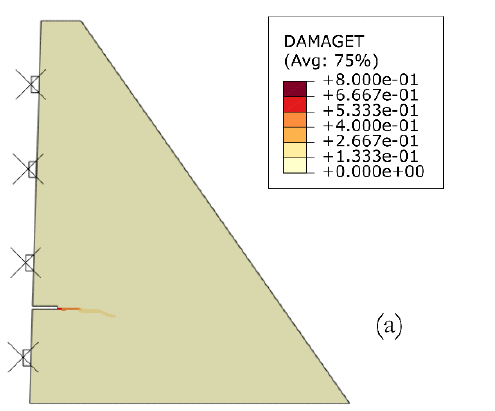
Figure 10. Combined results for mesh 02 including: ( a ) convergence requirements and elapsed sim- ulation time; ( b ) horizontal load for a given increment number; and ( c ) ratio of the LPF of the current increment and the highest LPF simulation value observed in the previous increments.